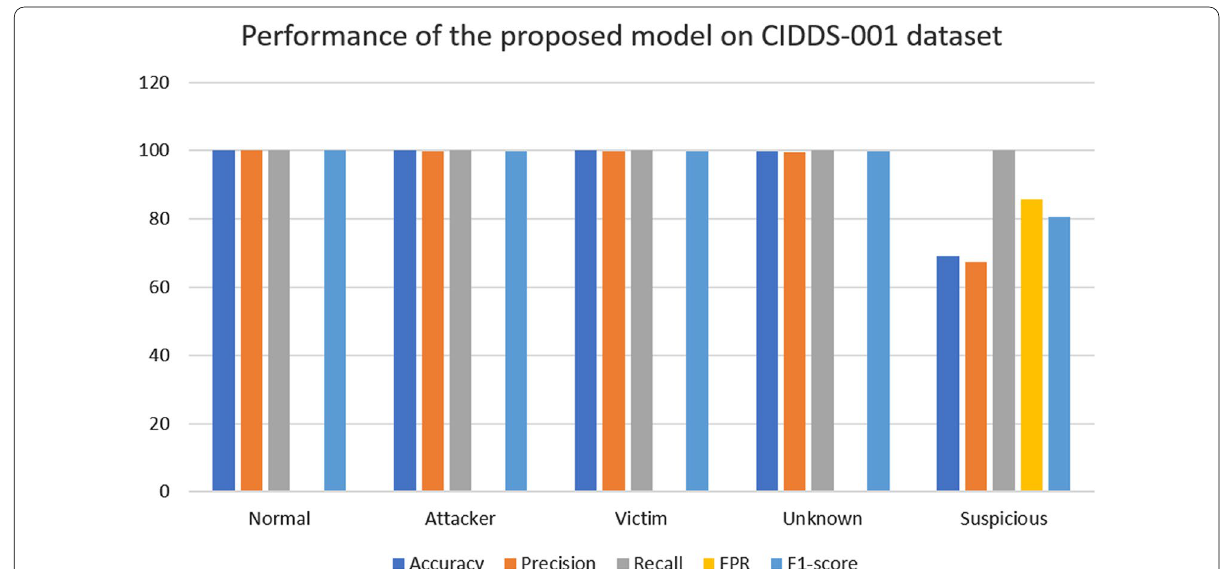
Fig. 9 Graphical representation for evaluation results of different classifiers in the proposed model on CIDDS-001 dataset for five classes of Normal, Attacker, Victim, Suspicious and Unknown for F1-score, FRP, Recall, Precision and Accuracy metrics